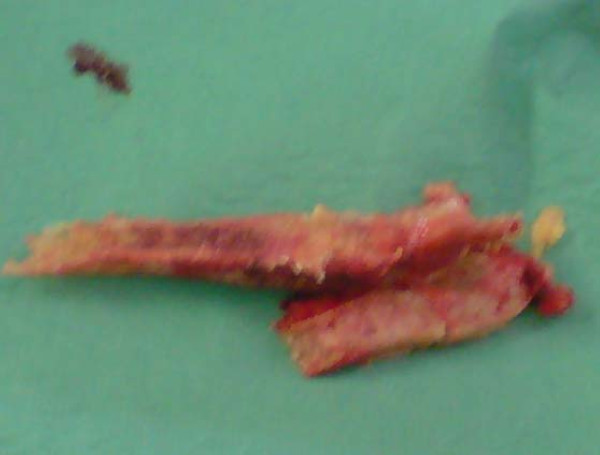
Sternal excision.